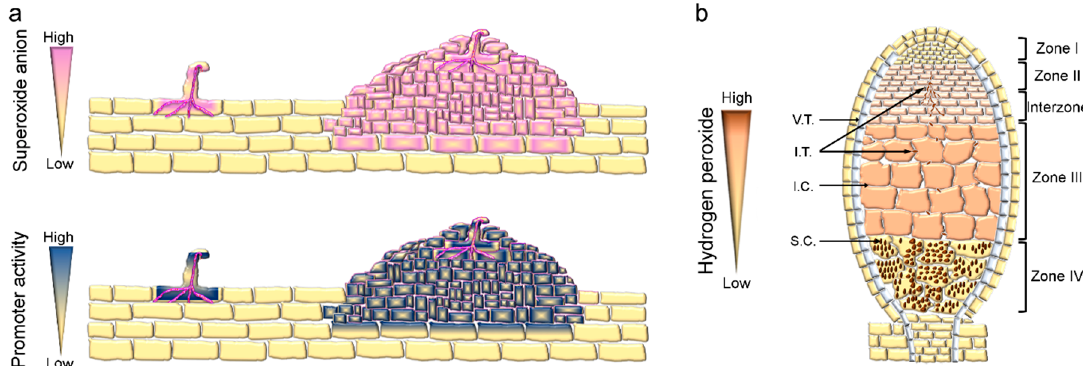
Figure 2. ROS production during nodule development and functioning. ( a ) Superoxide accumulation in the IT and nodule primordium of P. vulgaris (pink staining) correlates with the promoter activity of PvRbohB (blue staining) [9,52]. Superoxide is also generated in nodule primordia from indeterminate nodules [42]; ( b ) hydrogen peroxide is detected in vivo from Zone II to Zone III in M. truncatula nodules with the ROS-sensor Hyper [43]. Similarly, hydrogen peroxide is produced in the IT and senescent cells (cerium chloride detection method [54,55]). I.C., infected cell; I.T., infection thread; V.T., vascular